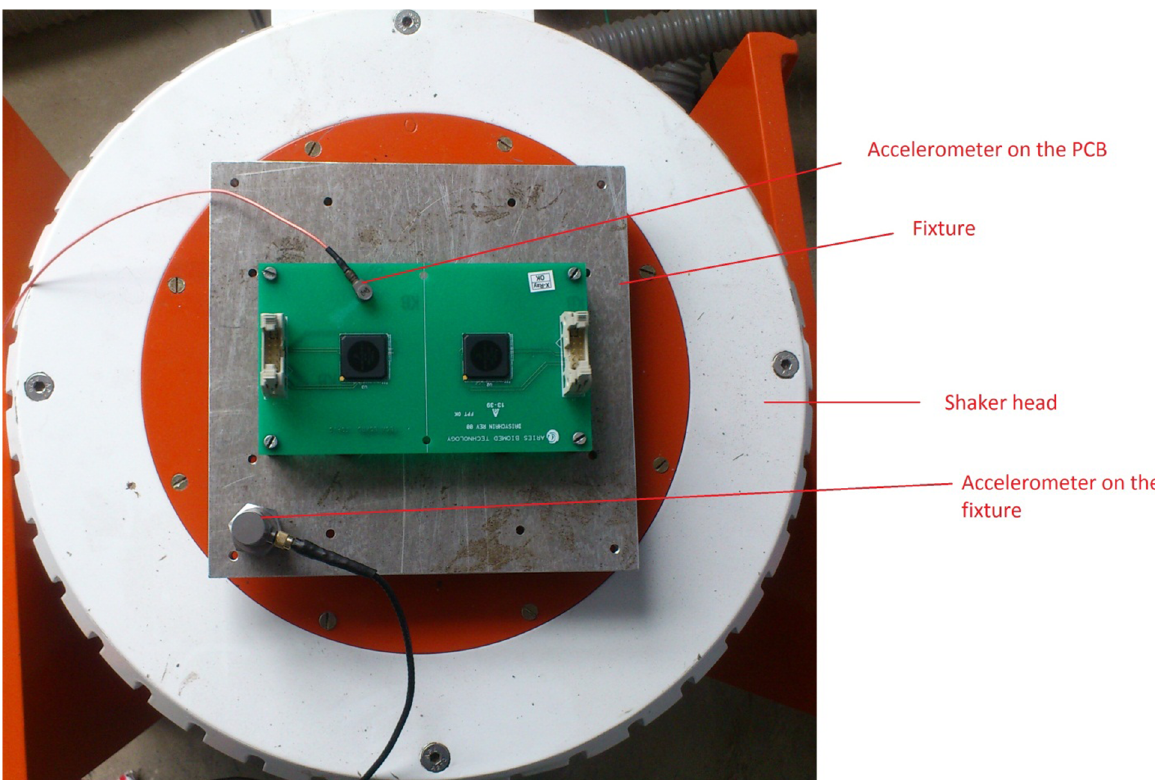
Fig. 11. The electronic package mounted on the shaker with a fi xture.